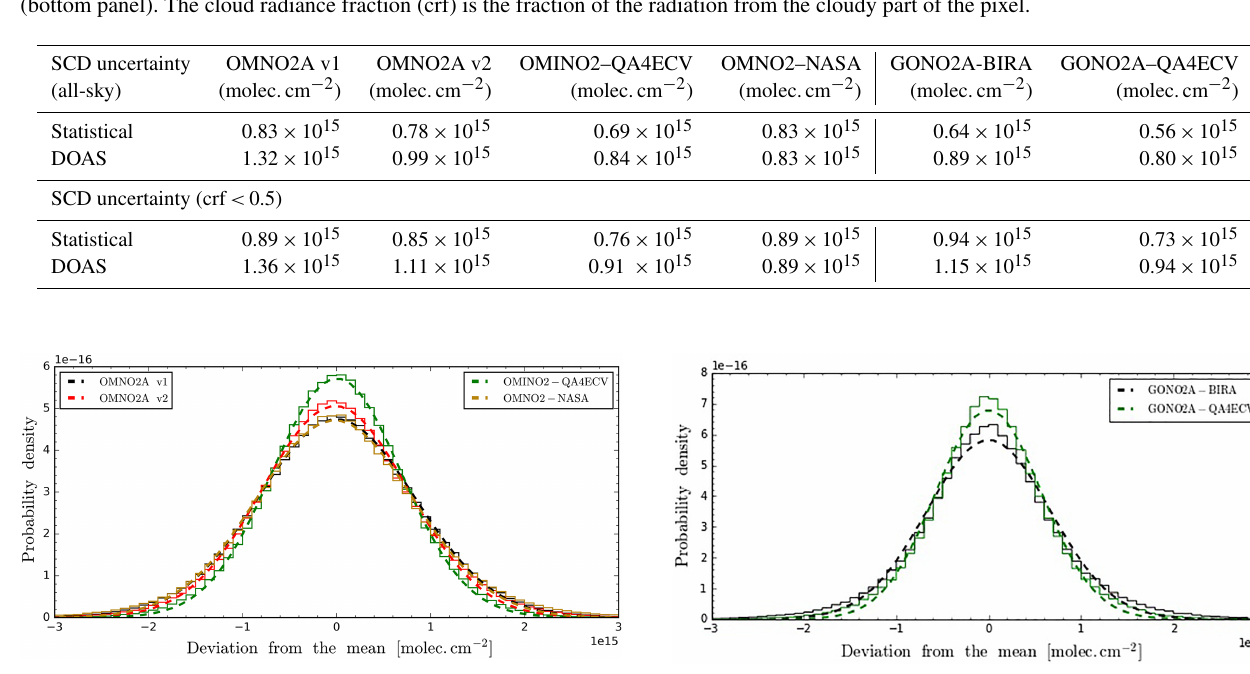
Figure 4. Distribution of the deviation of the OMI NO 2 SCDs from the mean SCD within a box (for all boxes) in a his- togram for OMNO2A v2 (red), OMINO2–QA4ECV (green), and OMNO2–NASA (yellow) algorithms against the reference OMNO2A v1 (black). The width, σ , of the Gaussian provides an estimate of the SCD uncertainty for each SCD retrieval algorithm ( σ v1 = 0 . 833 ± 0 . 003 × 10 15 molec.cm − 2 , σ v2 = 0 . 776 ± 0 . 005 × 10 15 molec.cm − 2 , σ qa4ecv = 0 . 688 ± 0 . 003 × 10 15 molec.cm − 2 , σ nasa = 0 . 829 ± 0 . 006 × 10 15 molec.cm − 2 ) . The histogram contains contributions from all boxes within the reference sector for the Pa- cific orbit from day 1 of January, April, July, and October 2005– 2015. No cloud screening has been applied.